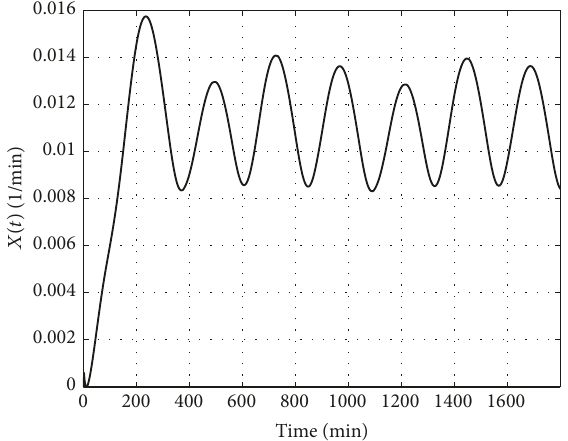
Figure 17: Variation of the insulin-excitable tissue glucose uptake activity over time.